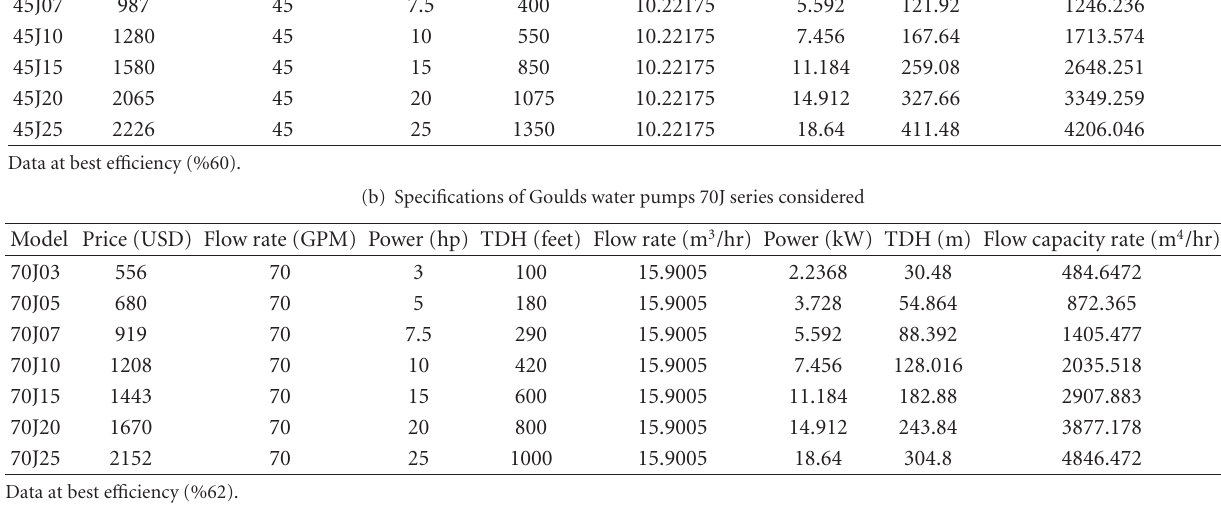
Table 8: Cost of solar PV water pumping from a well with 50 m TDH. Location Cost of water pumping with TDH = 50m (US¢/m 3 ) Dhahran 2.69